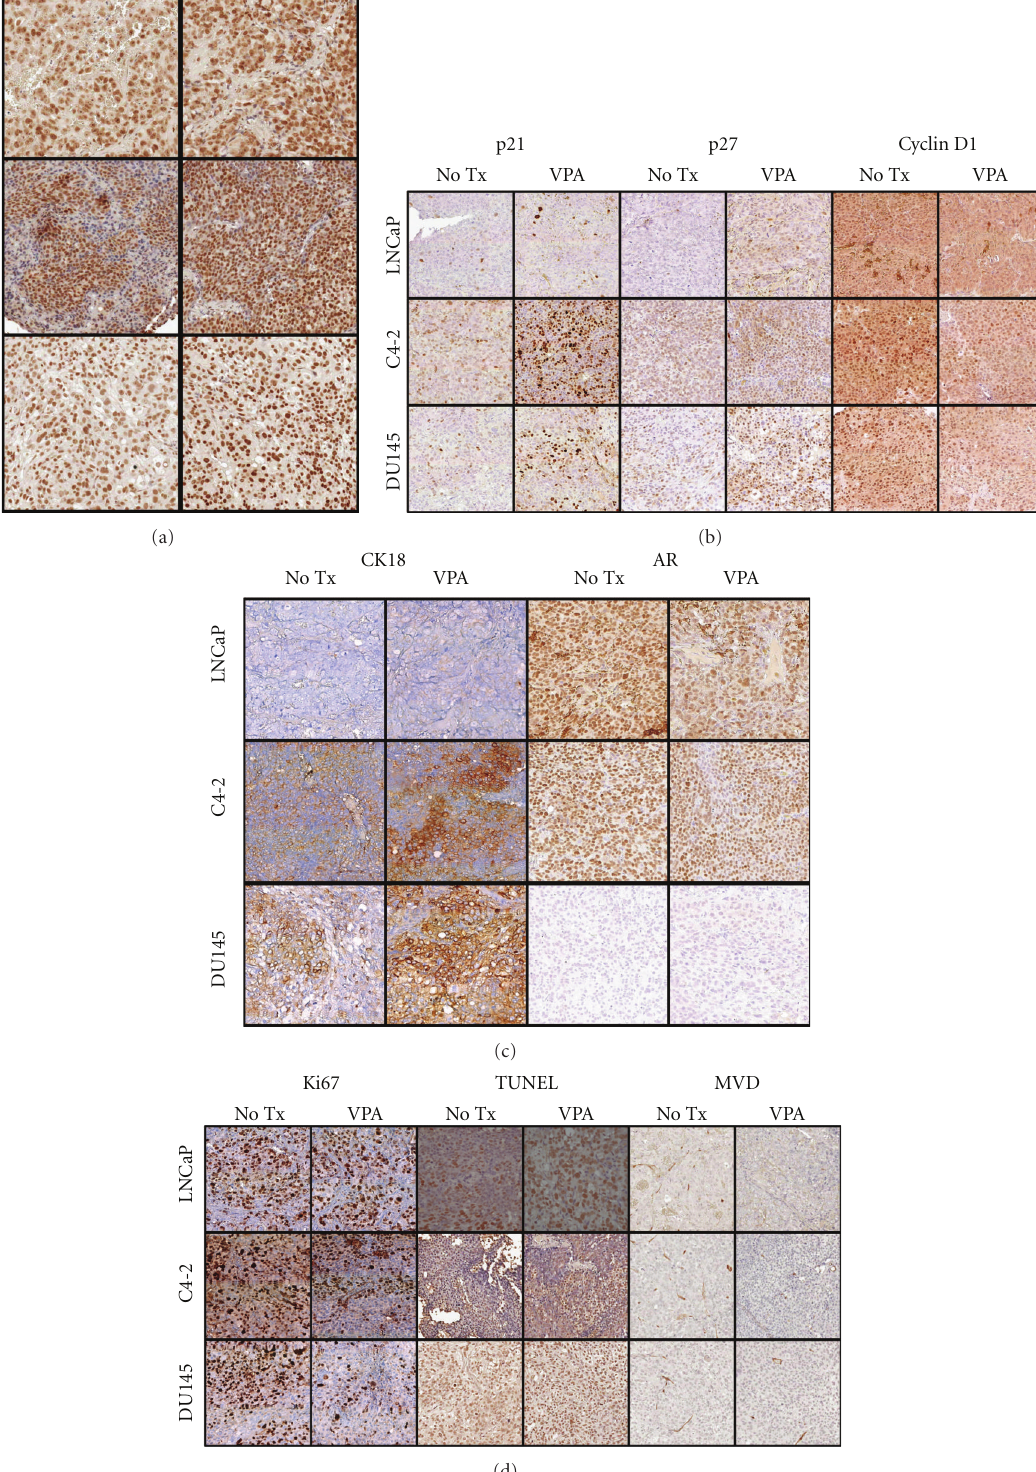
Figure 1: Animals with prostate cancer xenografts were randomized into control and treatment arms. Animals in treatment arm received 0.4% w/v Valproic Acid (VPA) in drinking water. Animals were treated for 35 days before excision of tumors. Tissue Microarrays (TMAs) of xenografts were created and expression of various markers was studied. Representative images of xenograft sections from control and VPA-treated groups; LNCaP, C4-2, and DU-145 (scanned at 20x magnification using the APERIO imaging system) are shown. (a) Immunohistochemistry (IHC) staining for acetylated histone 3. (b) Staining of cell cycle regulators (p21, p27, cyclin D1). (c) Staining for di ff erentiation markers (Cytokeratin 18 (CK18), androgen receptor (AR)). (d) Staining for markers of proliferation (Ki-67), apoptosis (TUNEL), and angiogenesis (mean vascular density,